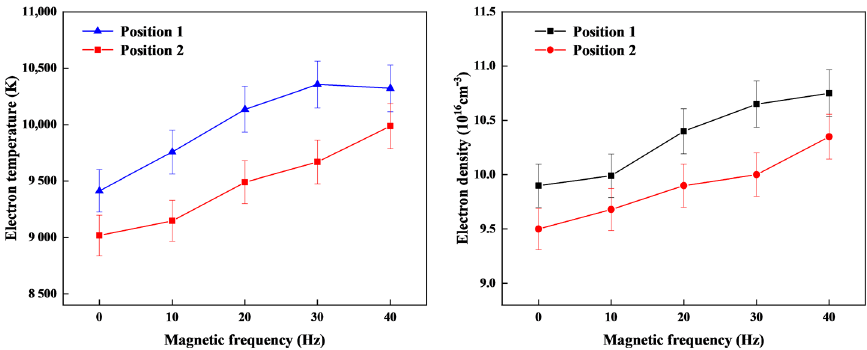
Figure 8. Effect of magnetic frequency on electron density and temperature at different positions.